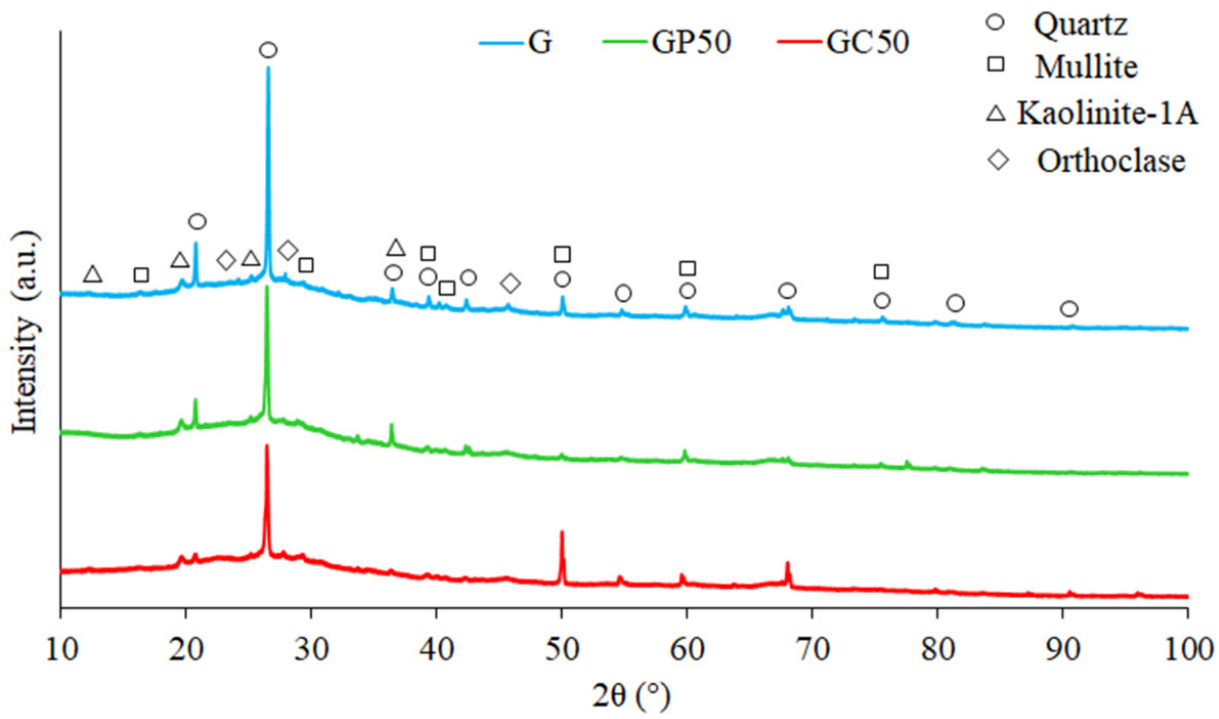
Figure 2. XRD patterns of foamed geopolymer and composite materials with different compositions.